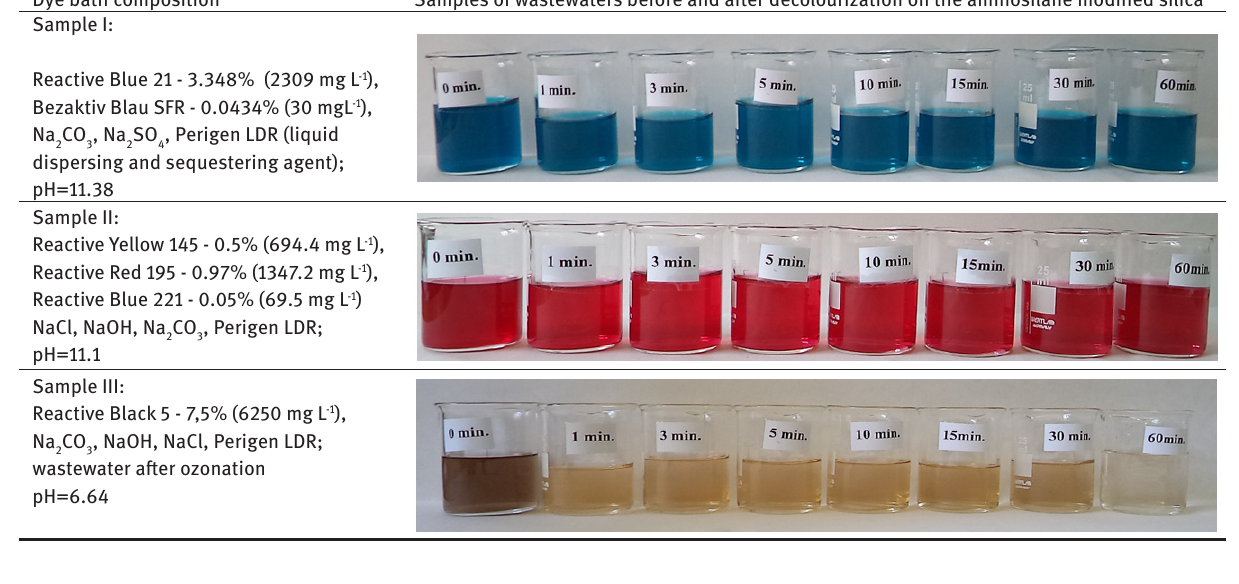
Table 4: Photo images of the wastewaters samples before and after sorption on the aminosilane modified silica. Dye bath composition